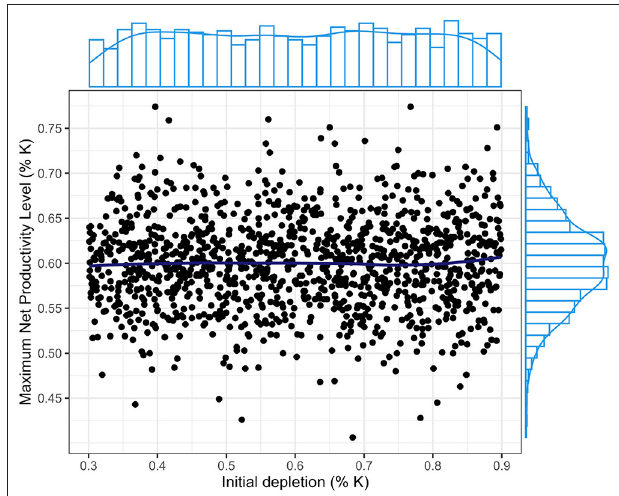
FIGURE 3 | Inputs for simulations with the Removals Limit Algorithm (RLA). A uniform distribution is induced on the initial depletion level and a normal distribution centered on 0.6 for the Maximum Net Productivity Level (MNPL).